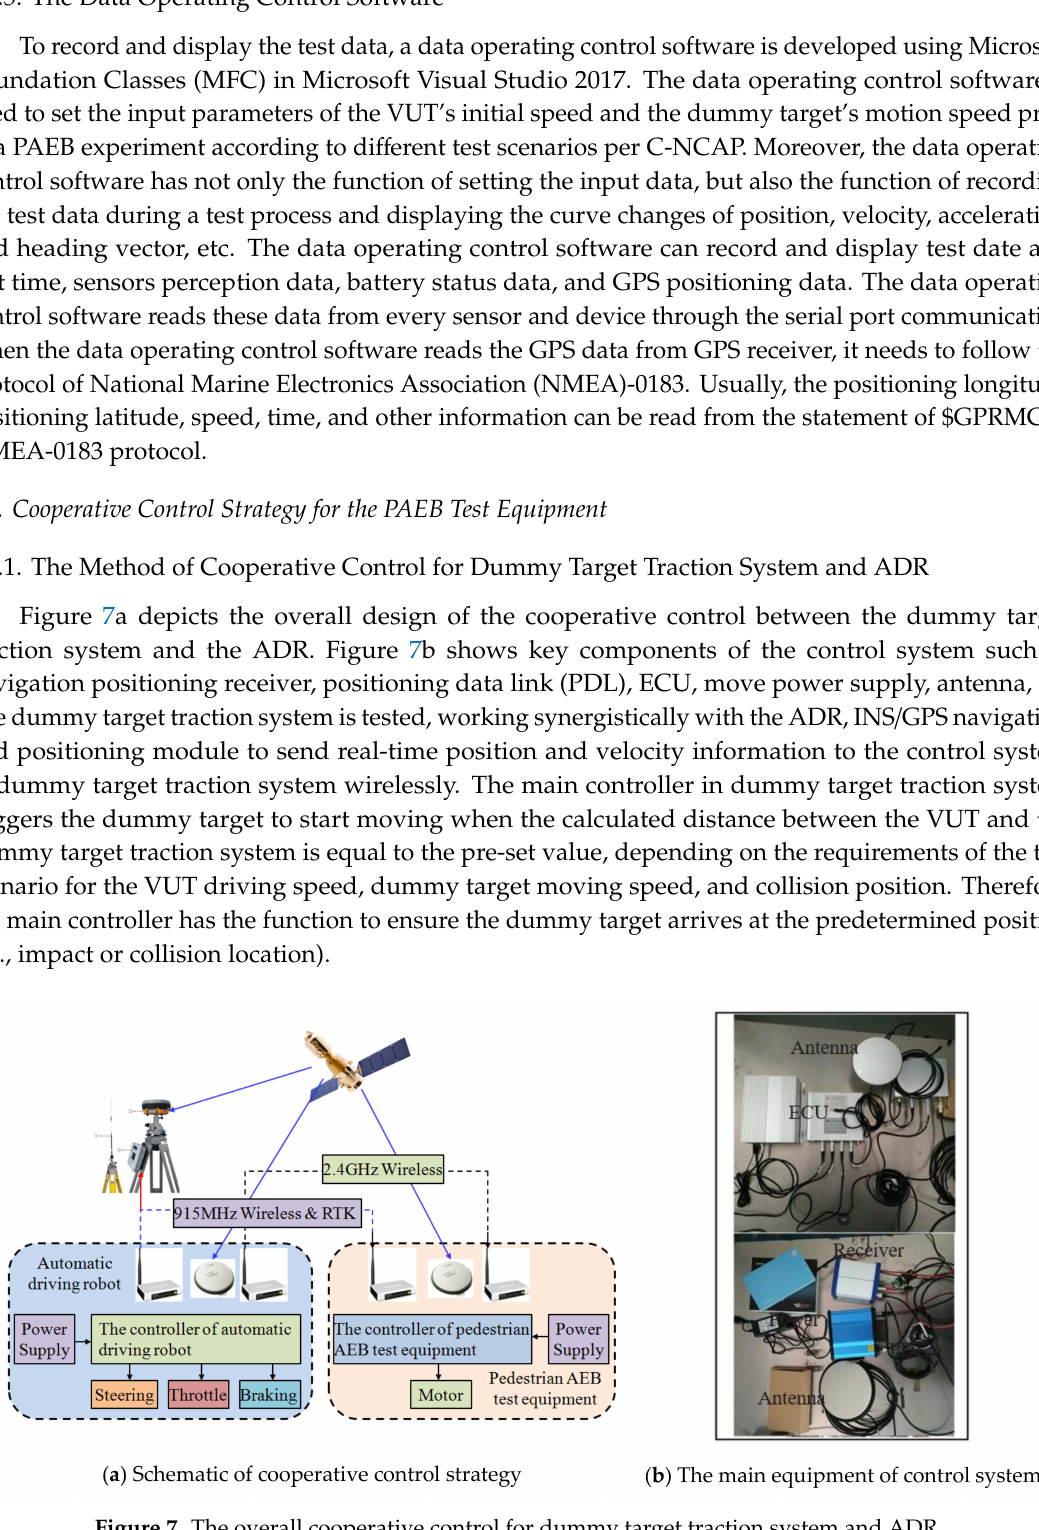
Figure 7. The overall cooperative control for dummy target traction system and